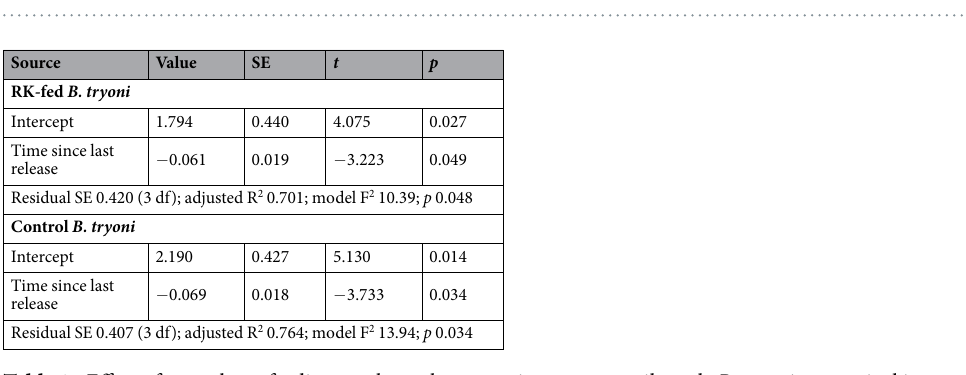
Figure 1. Survival of sterile male B. tryoni when fed a raspberry ketone (RK) supplemented diet when immature. ( a ) Survivorship curves show the daily survival ( b ) mean survival after 5 weeks. Means followed by the same letter are not significantly different (p > 0.05).